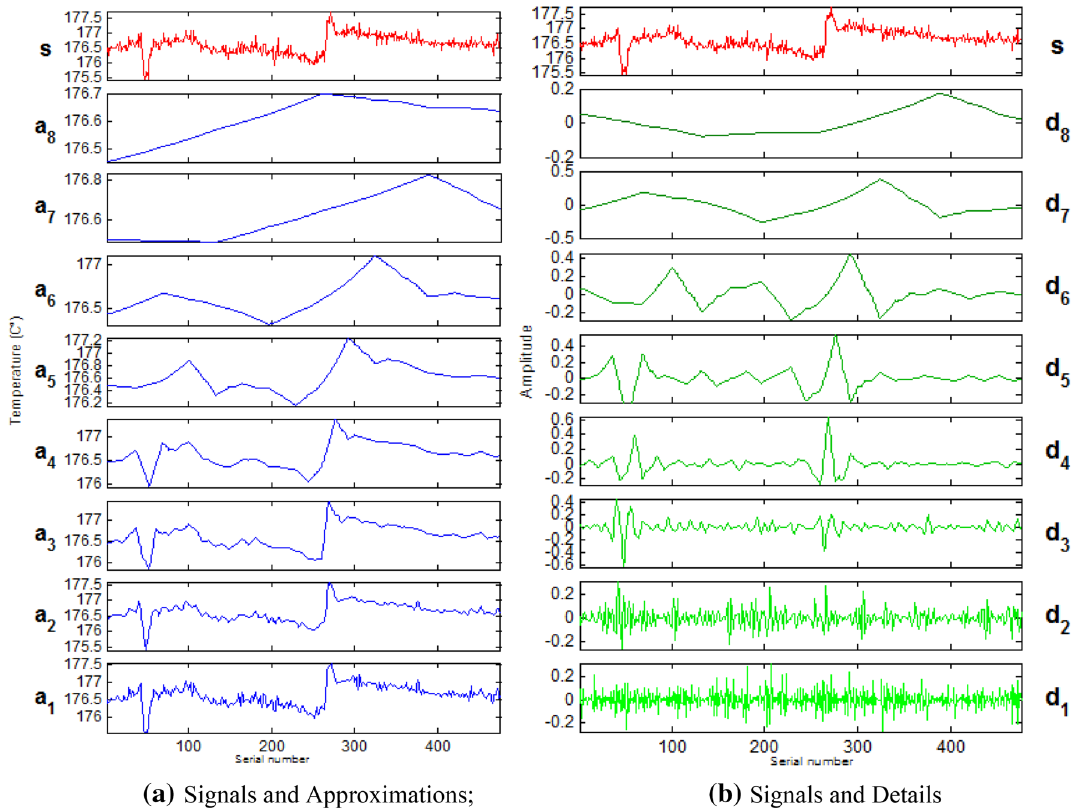
Fig. 9 Approximate and detailed signal of wavelet transform applied to the temperature data. a Signals and approximations; b signals and